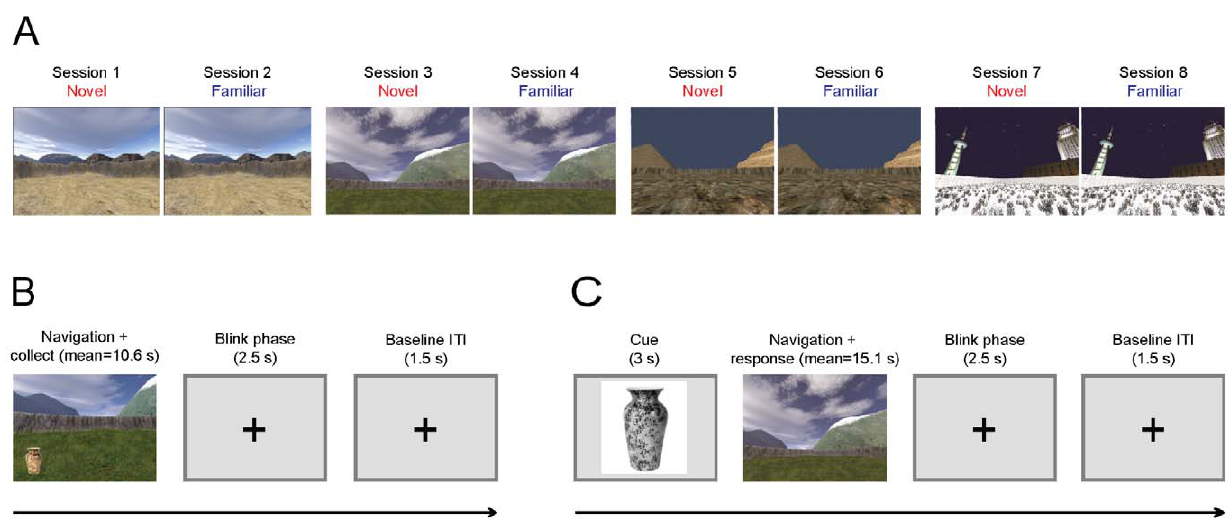
Figure 1. Overview of design and spatial memory task. (A) Experimental environments shown from the participants’ (first-person) perspective. Four different environments are presented in eight experimental sessions. The first two sessions (always the desert environments) provided practice outside of the MEG scanner. Sessions 3–8 contained three novel-familiar environment repetitions with environment order, counterbalanced across participants. (B) Learning phase trial structure. During learning trials, participants use a button box to navigate and ‘‘collect’’ novel and familiar (previously presented) objects (vase shown as example). (C) The test phase, trial structure. After being cued for 3 s with a picture of an object that had been collected in the learning phase of the current session, participants were placed back in the environment and had to navigate to where they thought the object had been located during that learning period.